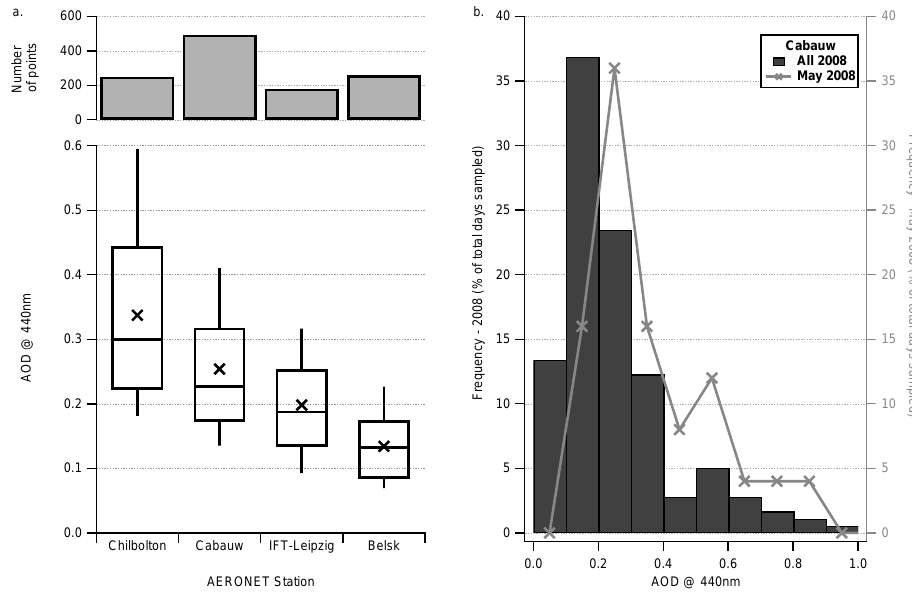
Fig. 2. Panel (a) displays boxplot summary statistics for AOD derived from AERONET stations in Northern Europe during the LONGREX high pressure period (6–14 May 2008). Crosses represent the mean value, while horizontal lines represent the 25th, 50th and 75th percentiles. The whiskers represent the 5th and 95th percentiles. Panel (b) displays a histogram of daily mean AOD at Cabauw for the year 2008 (left axis) and May 2008 (right axis). The values are normalised to the total number of days sampled in each case, which equaled 179 for the year 2008 and 25 for May 2008.